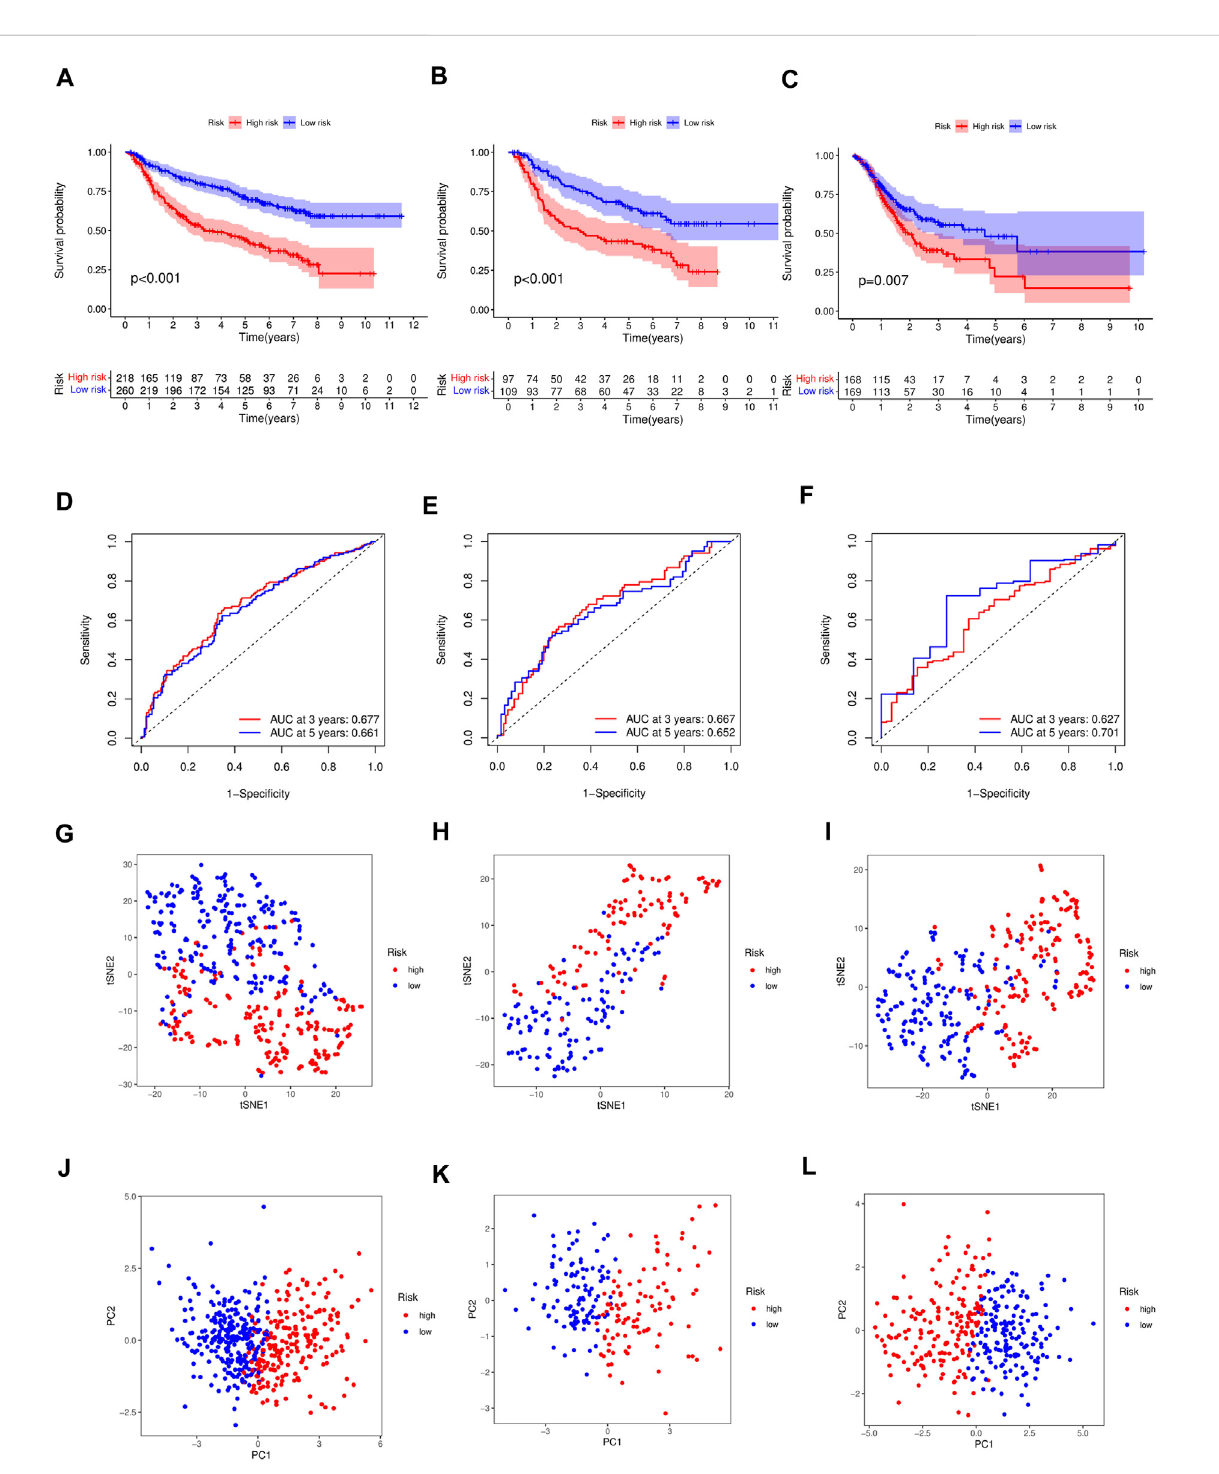
FIGURE 3 (A) Differences in survival between high-risk and low-risk groups of the training cohort ( p < 0.001). Differences in survival between high-risk and low-riskgroupsofthetestcohort( p < 0.001) (B) andexternalcohort( p =0.007) (C) . (D) Time-dependentROCanalysisoftheFASinthetrainingcohort. (E) Time-dependent ROC analysis of the FASin the test cohort. (F) Time-dependent ROC analysis of the FAS inthe external cohort. (G) The t-SNE plotin the trainingcohort. (H) Thet-SNEplotinthetestcohort. (I) Thet-SNEplotintheexternalcohort. (J) ThePCAplotinthetrainingcohort. (K) ThePCAplot in the test cohort. (L) The PCA plot in the external